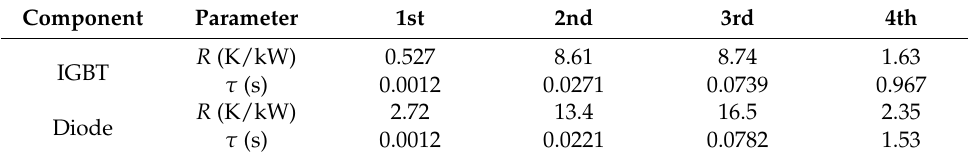
Table 2. Junction-to-case thermal impedance of power module FF1500R12IE5.